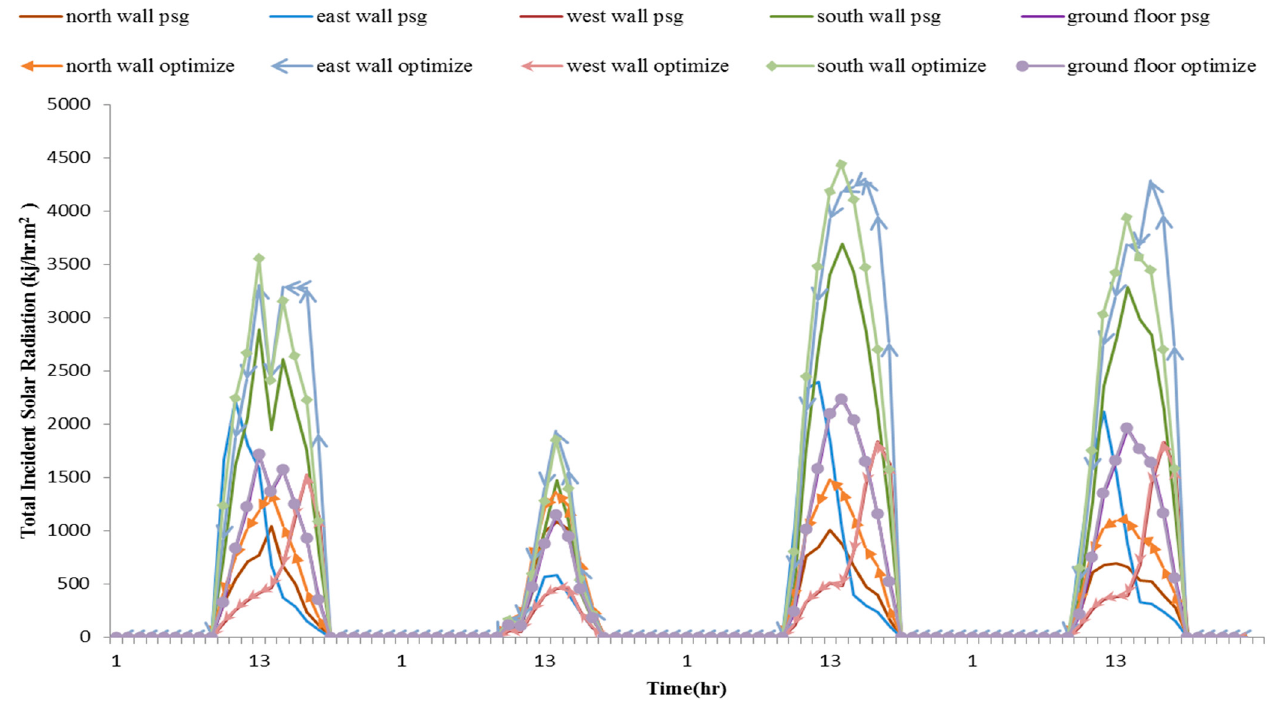
Energies 2021 , 14 , 5369 Figure 8. Total incident solar radiation in the conventional passive solar greenhouse and the optimized model.